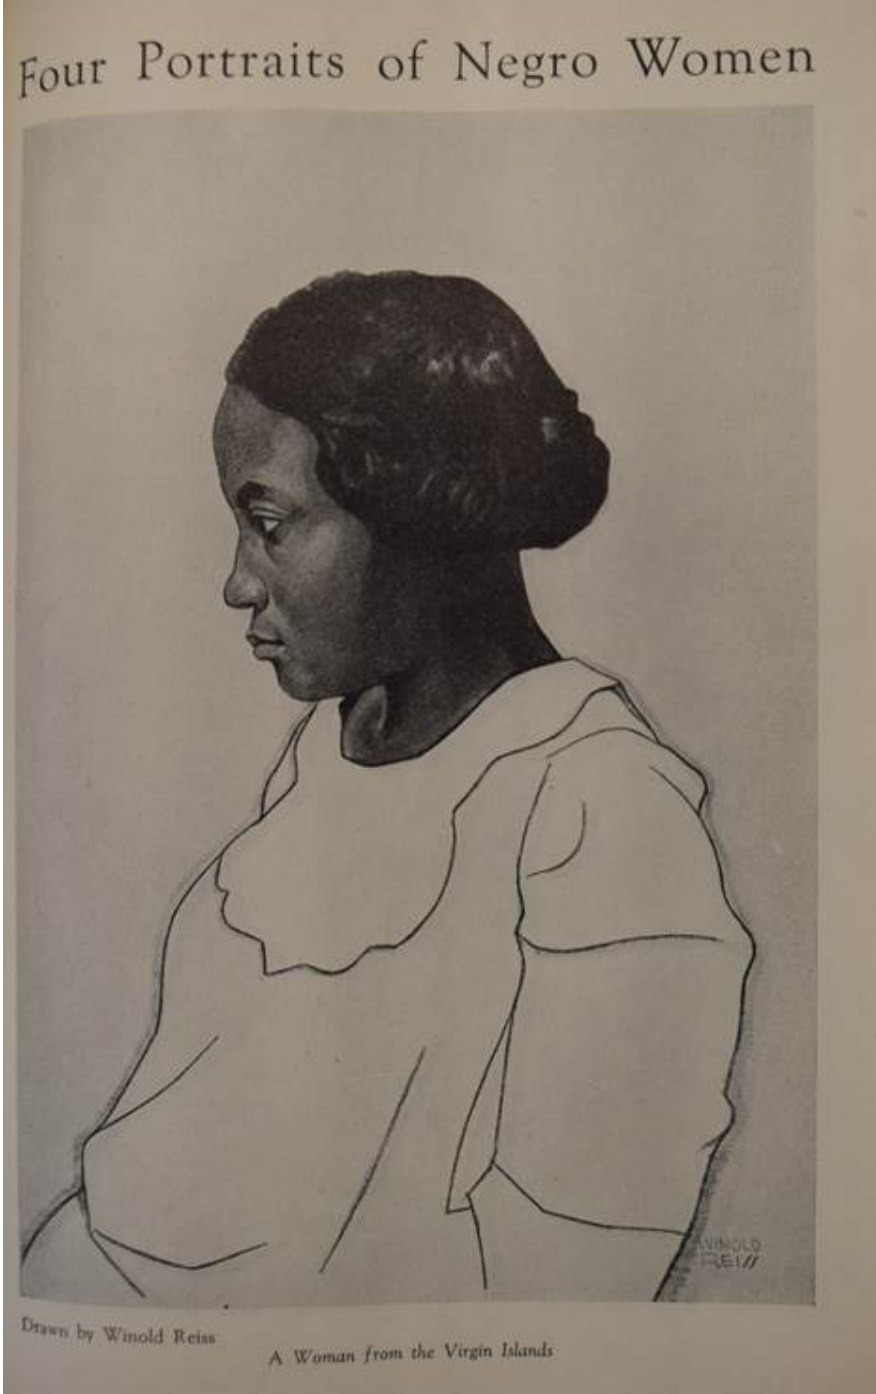
Figure 10 Winold Reiss, ‘A Woman from the Virgin Islands’, Survey Graphic 6, No. 6 (March 1925), 685 (Courtesy: London School of Economics Library); reprinted as Winold Reiss, ‘From the Tropic Isles’, The New Negro: An Interpretation , facing page